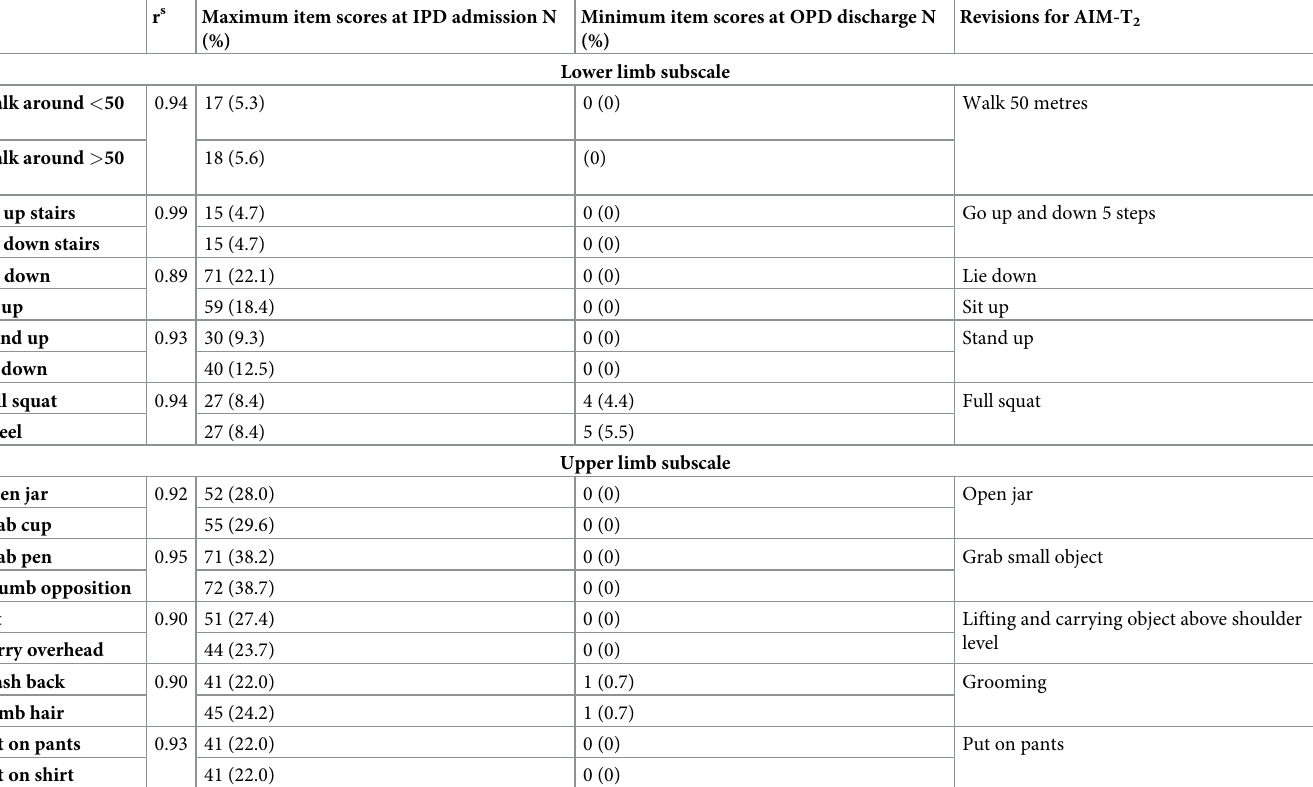
Table 3. Spearman correlation coefficients (r s ) for selected pairs of AIM-T 1 items within the lower limb and upper limb subscales in 635 patients (1207 assessments) and proportions of maximum AIM-T 1 scores at admission to inpatient departments (IPD) for lower (n = 321) and upper (n = 186) limb item scores and of mini- mum scores at discharge from outpatient departments (OPD) for lower (n = 91) and upper (n = 135) limb item